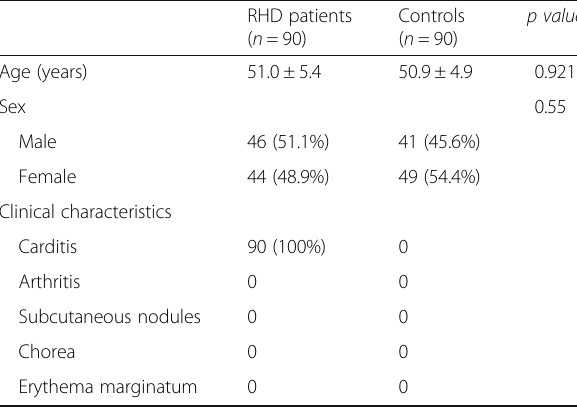
Age is represented as mean±SD RHD rheumatic heart disease, SD standard